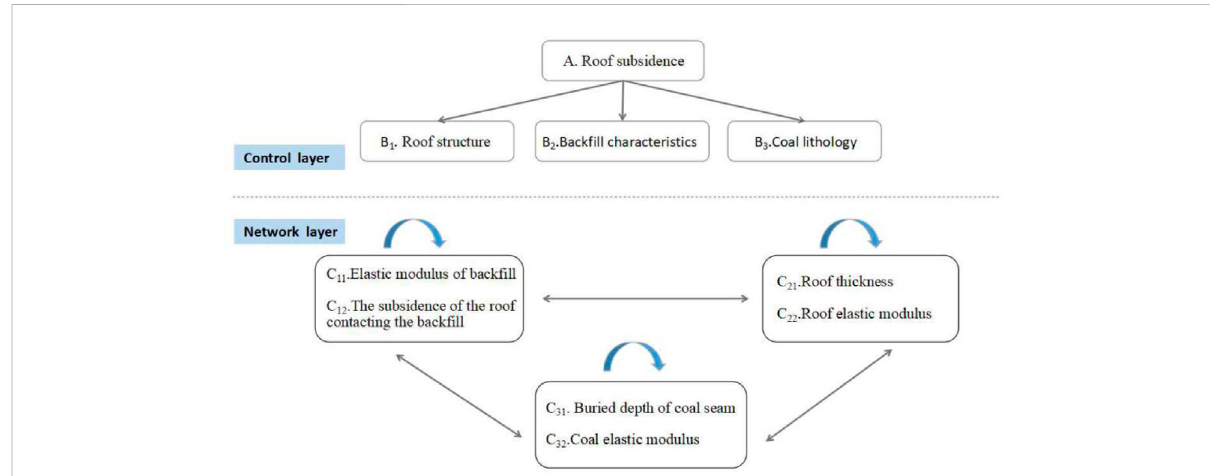
FIGURE 6 Three-cluster ANP network